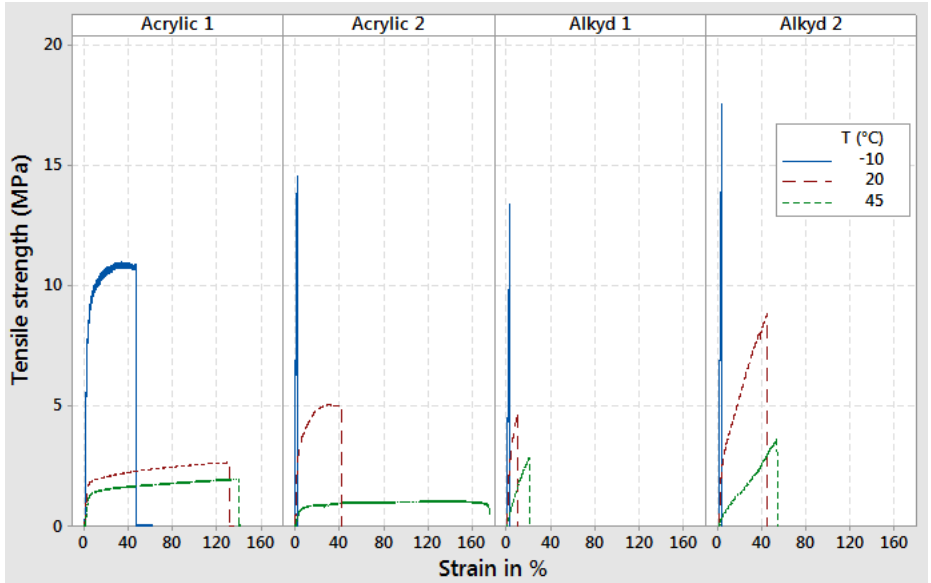
Figure 3. Comparison of the tensile strength–strain curves of the different coatings (examples with coatings 06, 18, 30, and 42 made with low PVC). Table 5. Ductile or brittle behavior of the coatings (examples for clear and low PVC coatings).